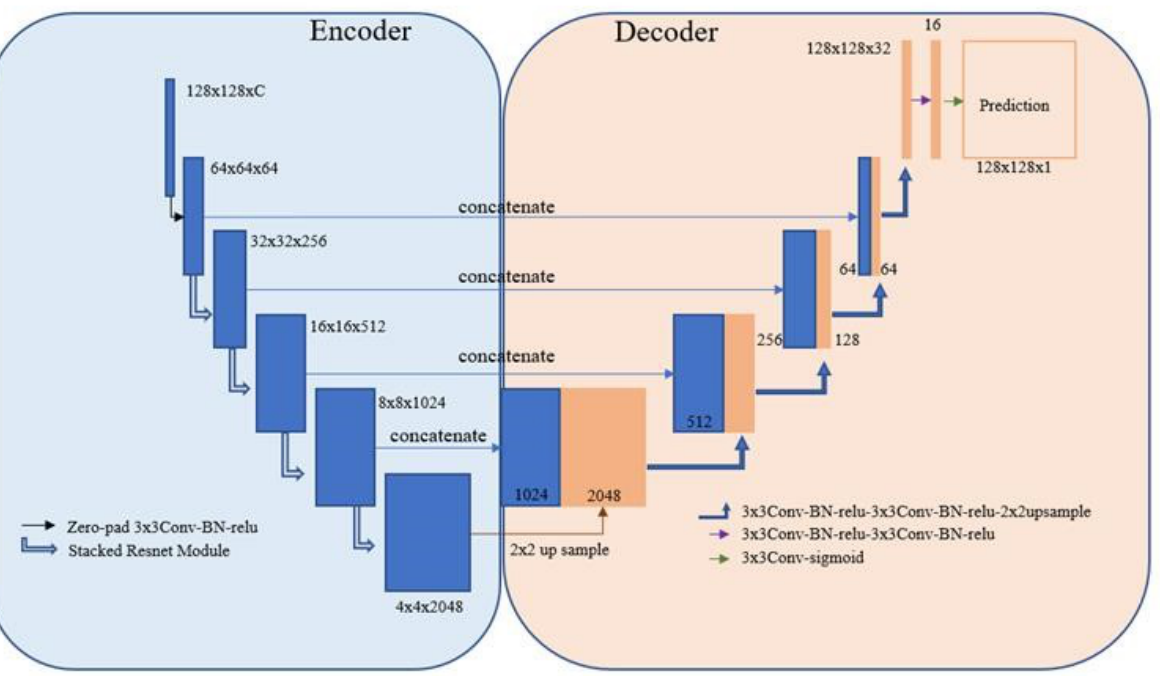
Figure 8. U-Net architecture with ResNet50 encoder.